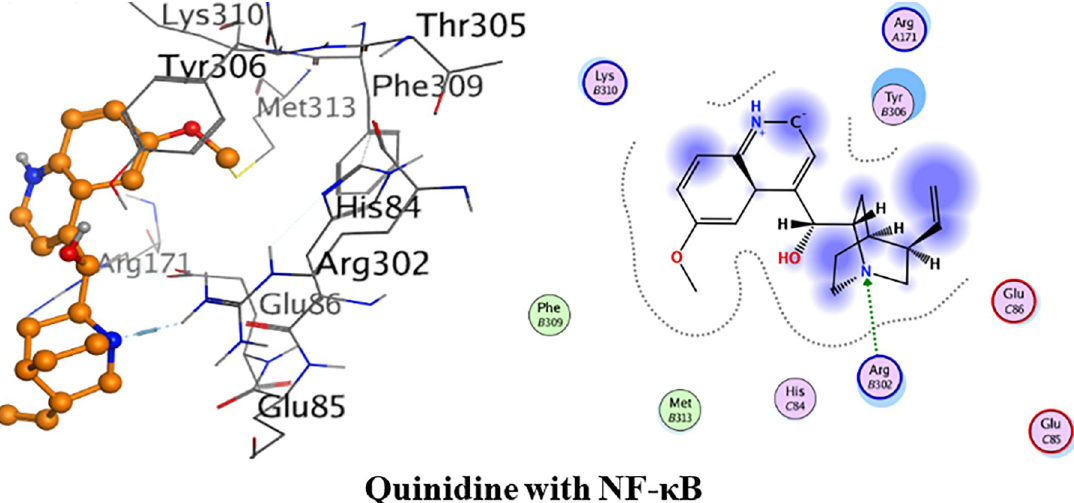
Fig 11. 3D and 2D interactions of quinidine with active site of nuclear factor kappa B (NF- κ B).